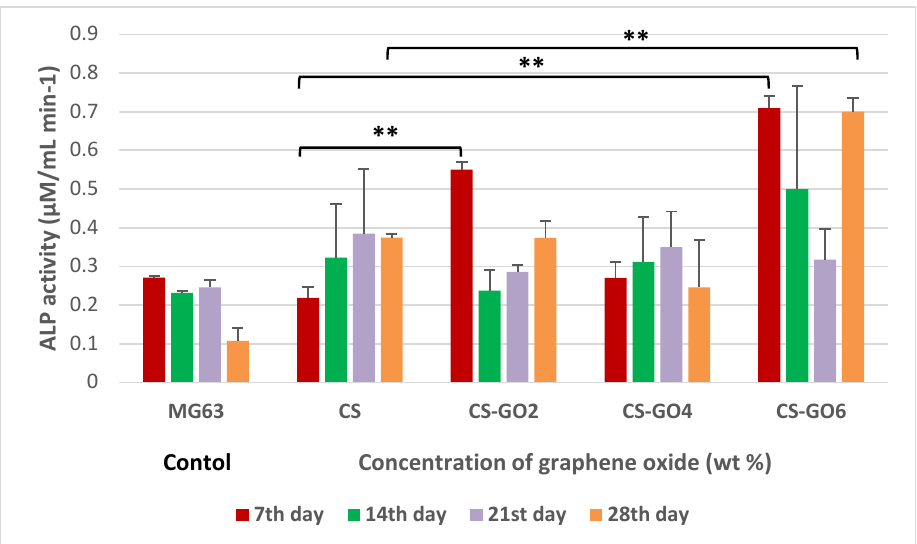
Figure 5. Histogram showing alkaline phosphatase (ALP) activity of MG63 cells on scaffolds on 7th, 14th, 21st, and 28th day post-seeding. Error bars represent standard error of means (SEM). Independent experiments were conducted in triplicate (** p < 0.001).